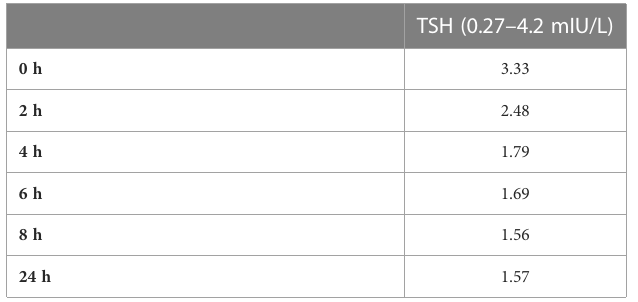
TABLE 2 Somatostatin sensitivity test.